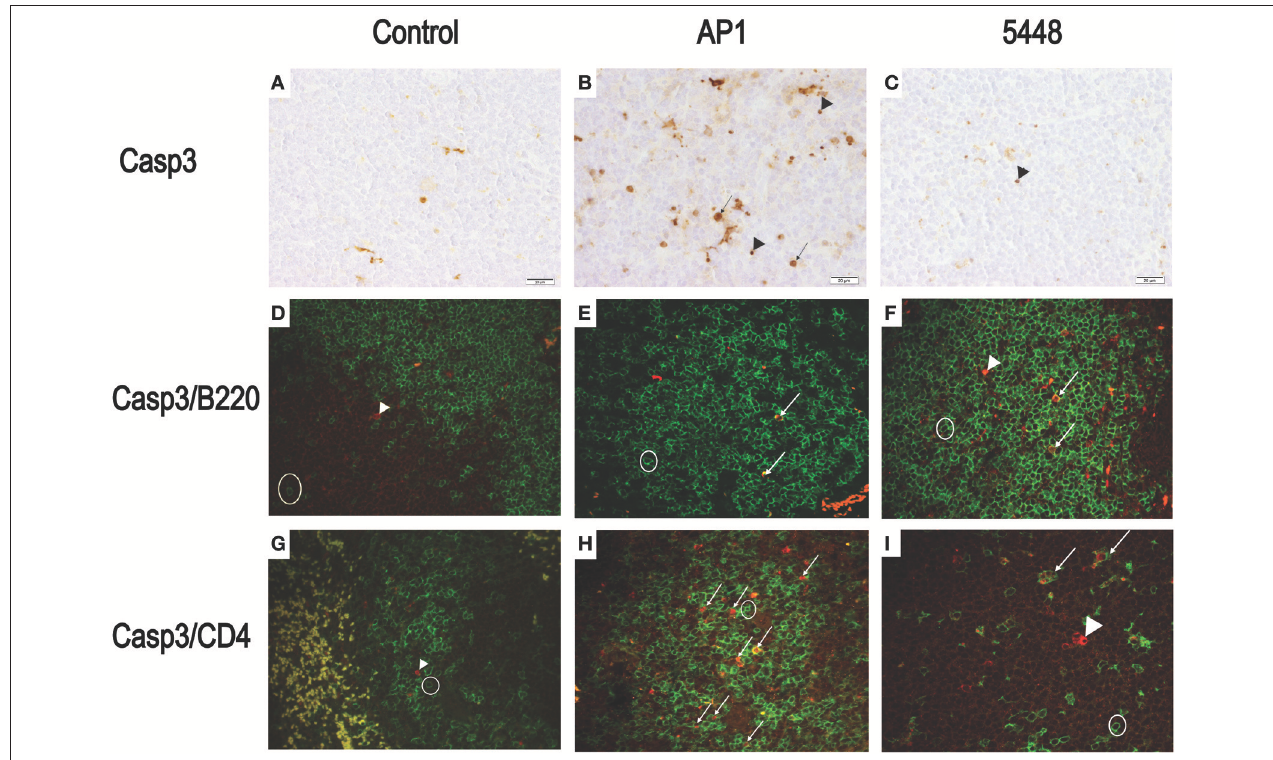
FIGURE 4 | Detection of apoptotic CD4 + and B220 + cells in white pulp of spleen. (A–C) Representative images showing cleaved Casp3 + cells detected by immunohistochemistry. The symbols point to selected cells illustrating the detection of cleaved Casp3 in cells with lymphoid appearance (arrowheads) and in cells with morphology consistent with macrophage or dendritic cells (arrows). (D–F) Double immunofluorescence showing cleaved Casp3 (red) expression in B220 + (green) cells. Circle = typical B220 single positive cell; arrows = double positive cells, defined as a red nucleus within green staining membrane or yellow stain resulting from superimposition of red and green signals due to breakdown of cellular compartments late in apoptosis. (G–I) Double immunofluorescence showing cleaved Casp3 + (red) and CD4 + (green) cells in splenic white pulp. Circle = typical CD4 + cell; arrowhead = cleaved Casp3 + cell; arrows = double positive cells (defined as in D–F ). Bars = 20 µ